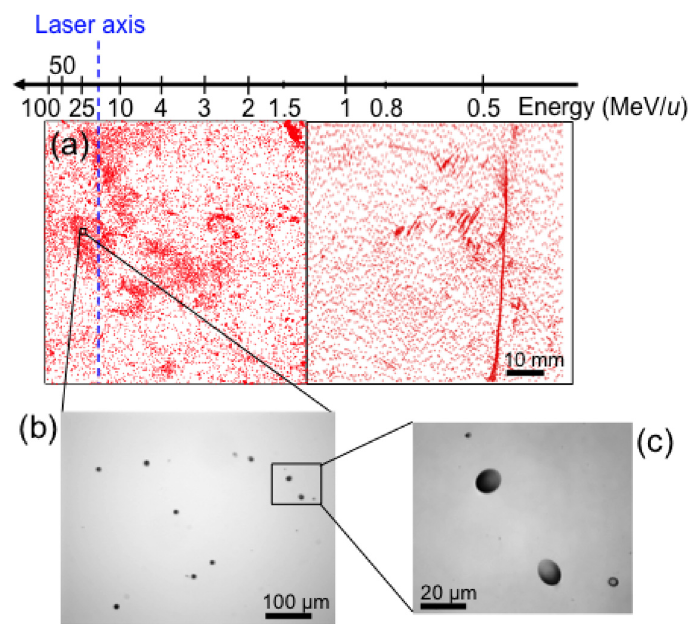
Figure 13. ( a ) Whole view of etch pit distribution on the rear surface of the 70 × 140-mm wide CR-39; ( b ),( c ) Typical images of etch pits on the rear